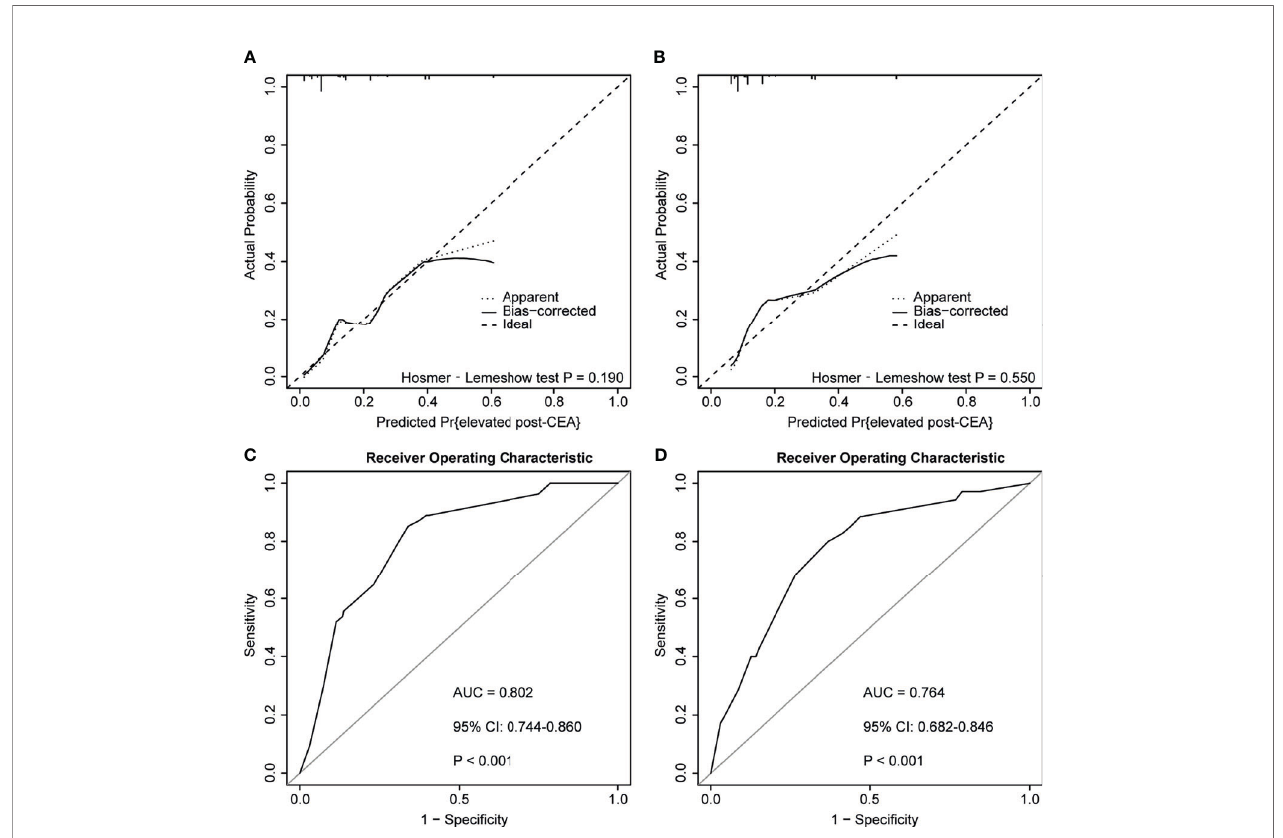
FIGURE 7 | Calibration curves and receiver operator characteristic curves (ROC) of the predictive model for predicting postoperative carcinoembryonic antigen (post-CEA) elevation in patients with colorectal cancer (CRC). (A, B) represented calibration curves of the model in the discovery and testing cohort, respectively. (C, D) represented ROC curves of the model in the discovery and testing cohort, respectively. AUC, area under the curve; CI, con fi dence